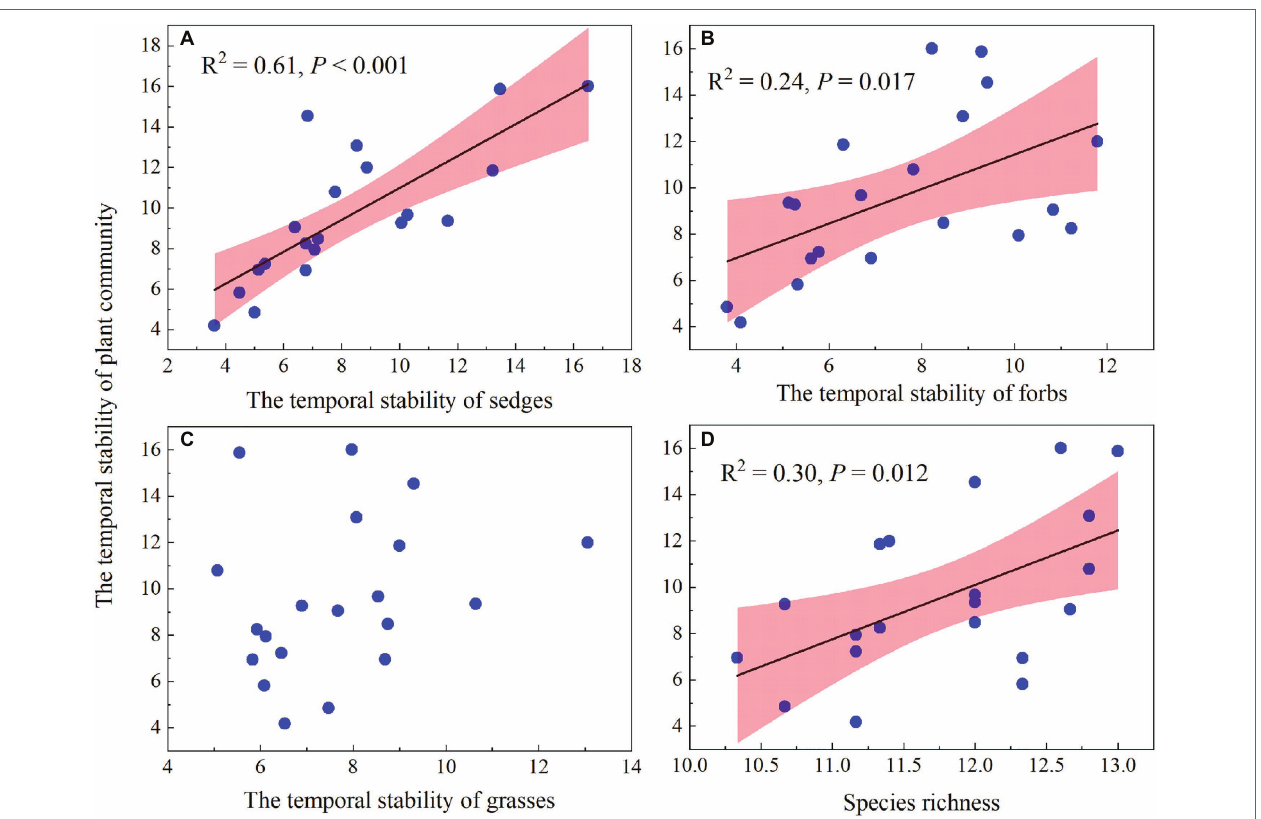
FIGURE 10 | Relationship of the temporal stability of plant community AGB and the temporal stability of sedges AGB (A) , the temporal stability of forbs AGB (B) , the temporal stability of grasses AGB (C) , and species richness (D) .